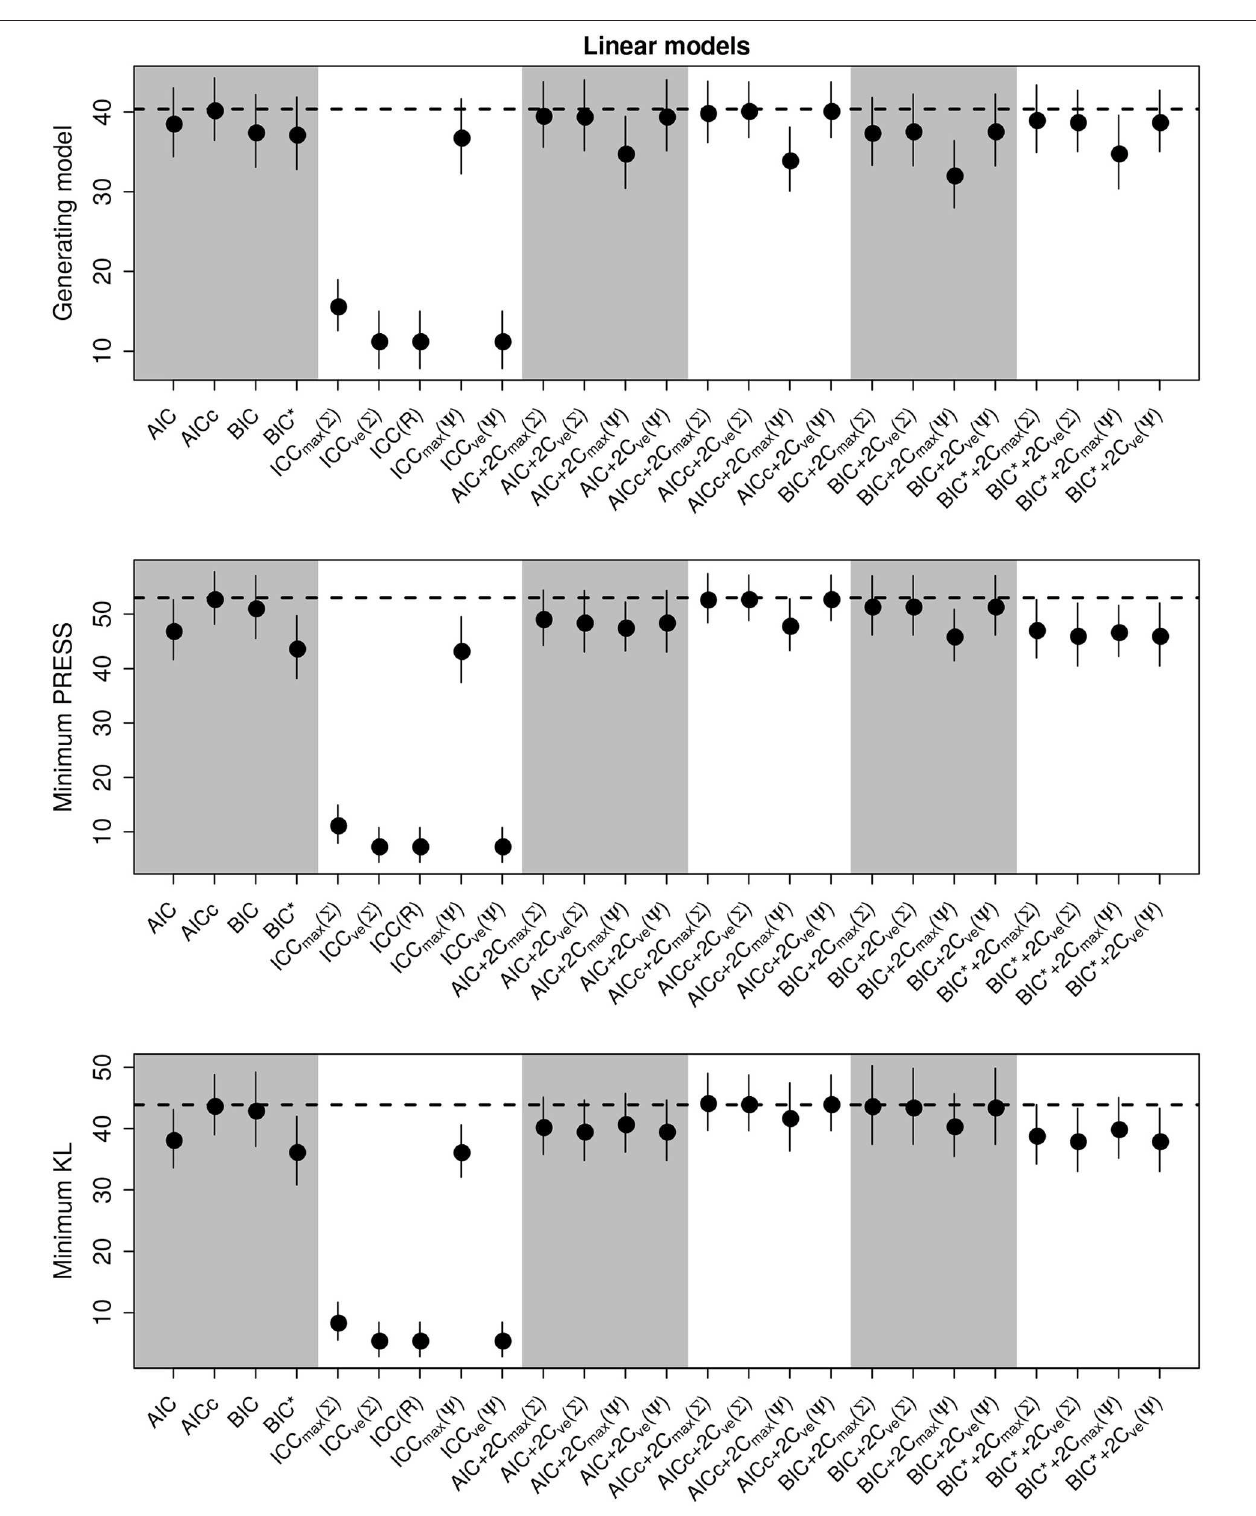
FIGURE 2 | Performance of the criterion for all selection goals for the linear model simulation experiment. Points are the average performance-level, bars give standard errors. The dashed horizontal line gives the performance of AICc for reference. The top panel gives the frequency that each criterion selects the model used to generate the data, the middle pannel gives the frequency of selecting the model that minimizes the predicted residual error sum of squares (PRESS), while the bottom panel gives the frequency of selection by the criterion of the model corresponding to the minimum Kullback-Leibler divergence (KL).